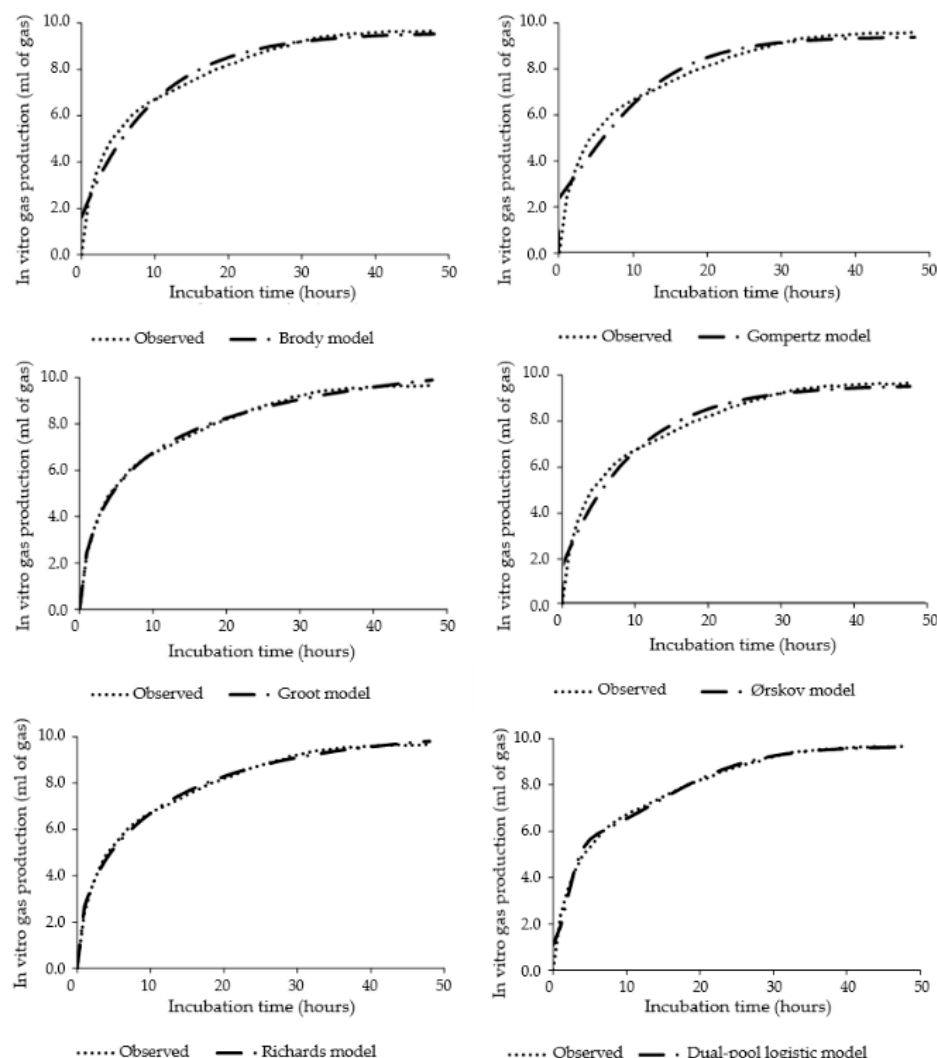
Figure 1. Curves of accumulated in vitro gas production of corn silage with probiotics and ionophore combination fitted in different models.